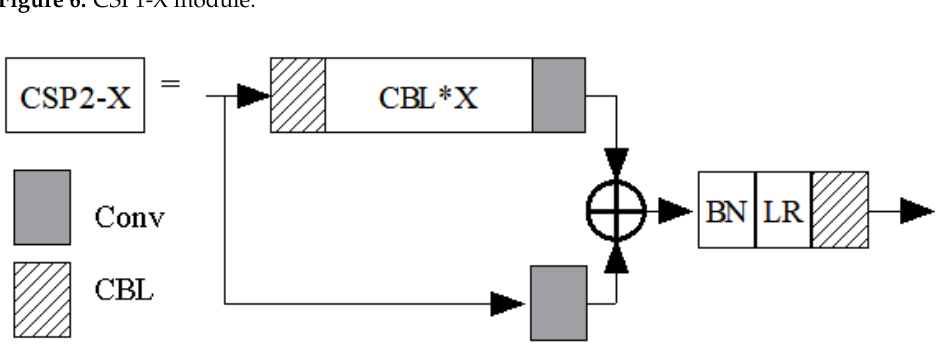
Figure 6. CSP1-X module.